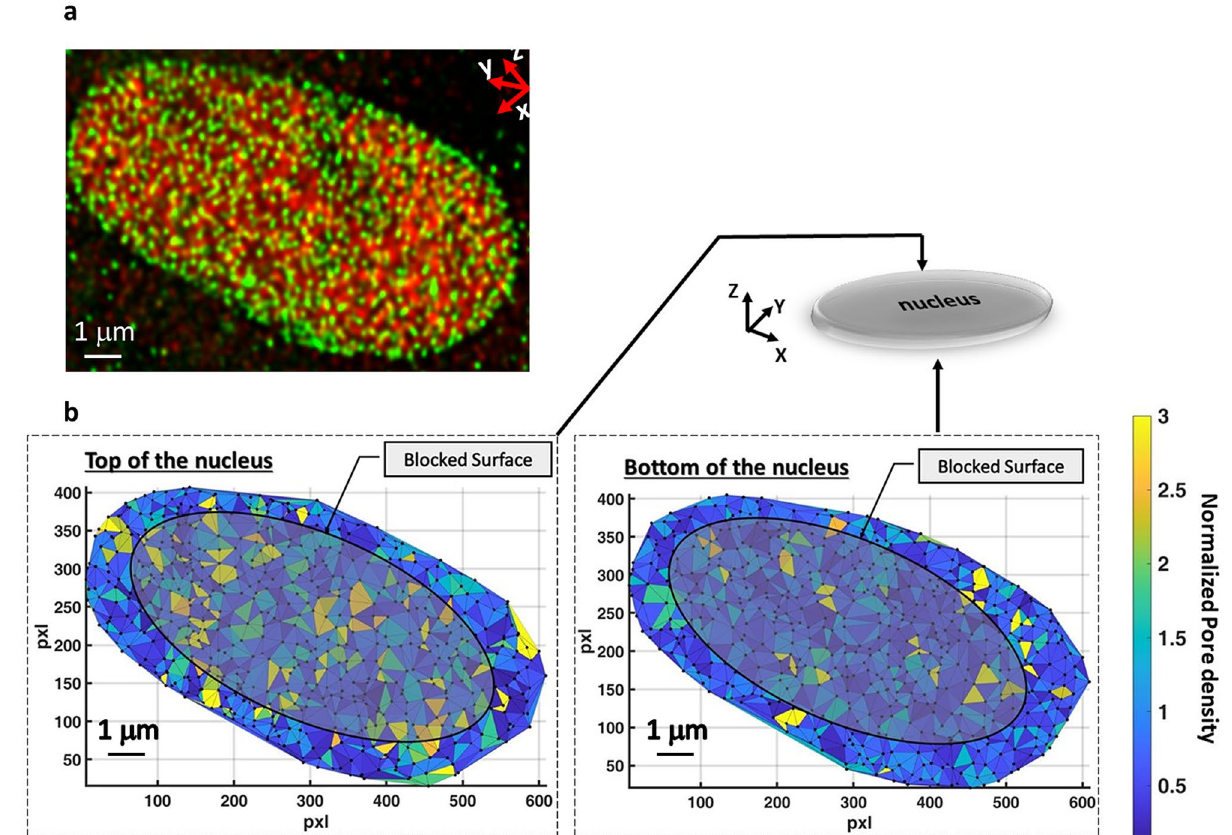
Figure 8. Mean nuclear flux and pore distribution. ( a ) 3D reconstruction of confocal z stack images. In green is visible the nuclear pore distribution and in red the DNA (Nup153 protein and H3K4me3 staining respectively). ( b ) Superimposition of the NPC nuclear localization and the transport-blocked surface; the surface is reconstructed by Delaunay triangulation method and the color shows the normalized NPC density at each triangle elements. The software used to create the two images is Matlab R2019b (https ://it.mathw